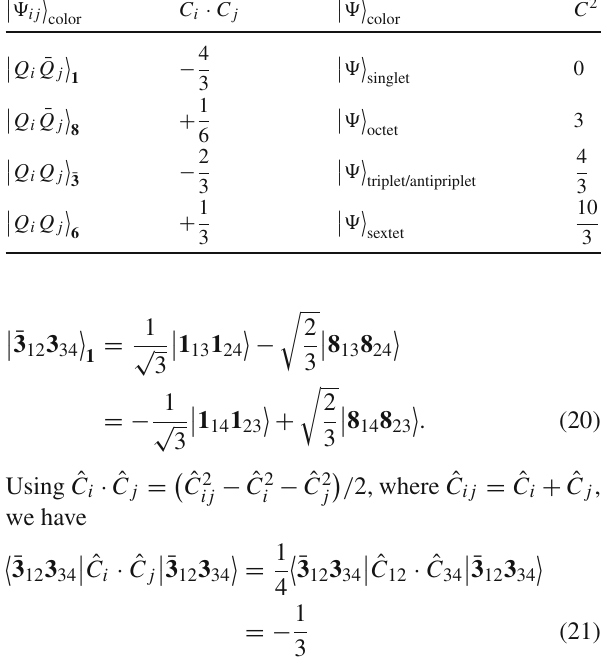
Table 2 Eigenvalues of the Casimir invariants ˆ C i · ˆ C j and ˆ C 2